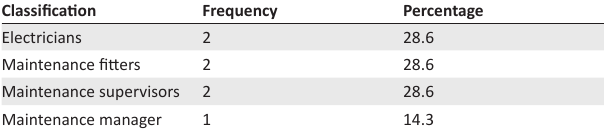
TABLE 3: Focus group of